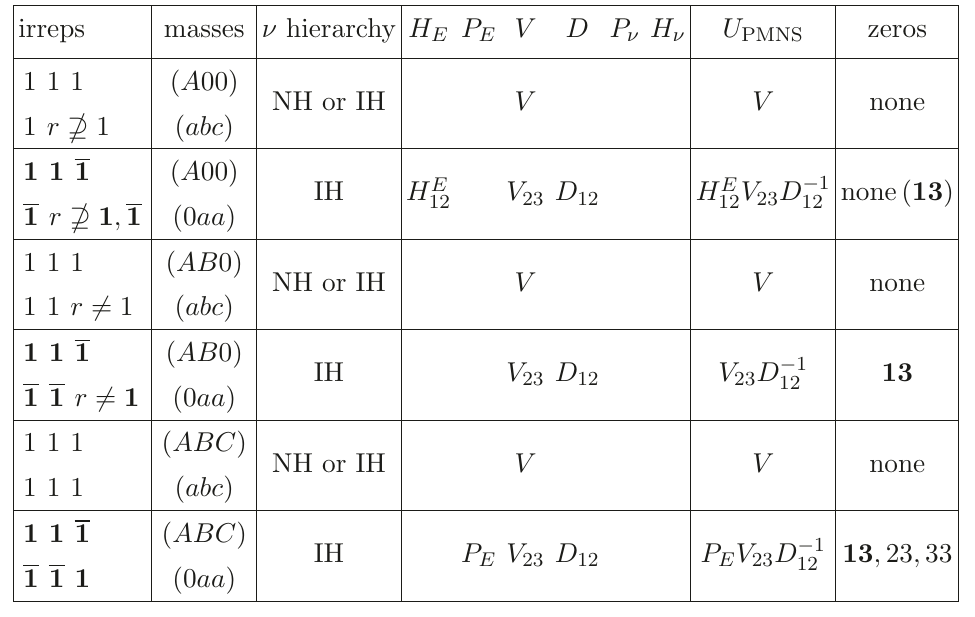
Table 4 . Irrep decompositions giving rise to a PMNS matrix with no zeros or a single zero possibly in the 13 entry. The first column shows the decomposition of U l and U e c , one above the other. Only real and complex irreps appear. The second column shows the corresponding pattern of charged lepton and neutrino masses in the symmetric limit, one above the other, and the third the neutrino hierarchy type, normal (NH) or inverted (IH). The individual contributions to the PMNS matrix are then shown. A matrix with no further specification is generic (e.g. P denotes a generic permutation, V a generic unitary matrix). D ij denotes a π/ 4 rotation in the generic form in eq. (2.6) acting in the sector ij . If no information on a certain factor is given, that factor is irrelevant (for example because diagonal or because it can be reabsorbed in another factor). The presence and position of a zero in the PMNS matrix in the symmetric limit is specified in the last